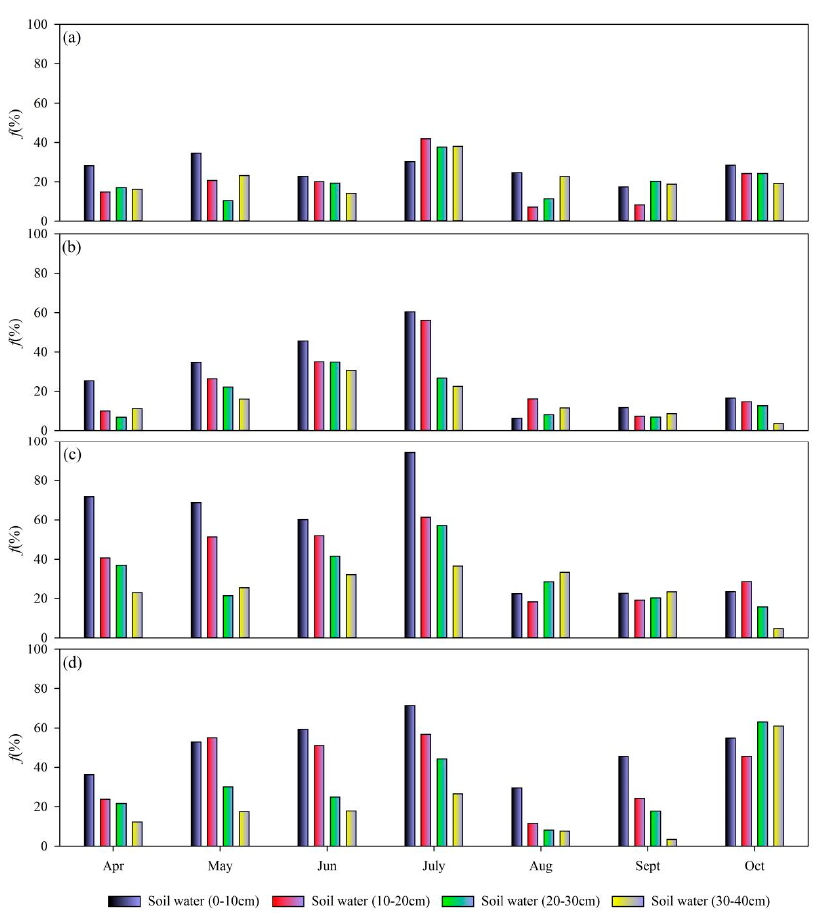
Figure 7. Monthly change of the 0 to 40 cm soil layer evaporation loss f at the four stations from April to October based on δ 18 O (( a ) Lenglong; ( b ) Ningchan; ( c ) Huajian; ( d ) Xiying).